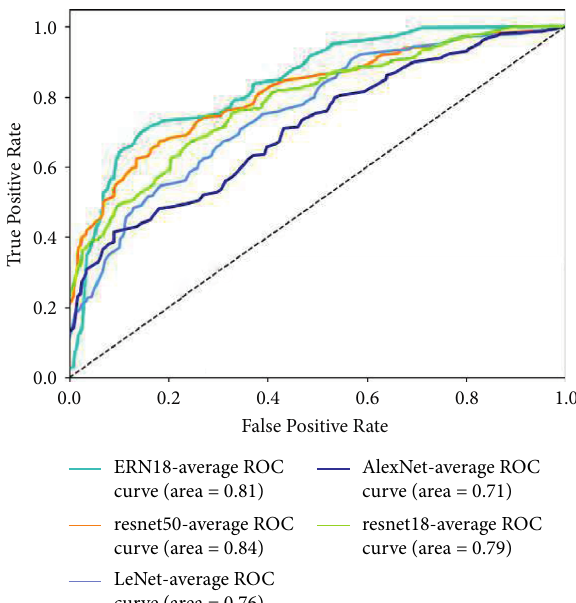
Figure 14: Comparison of ROC curves of each model.